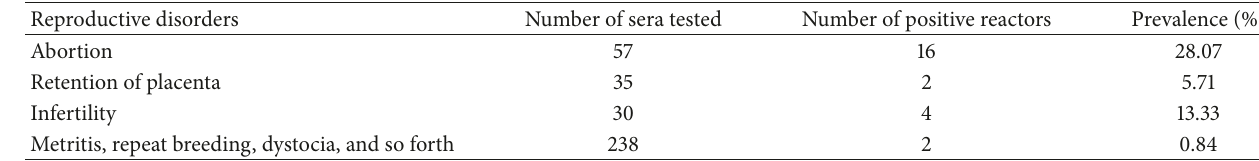
Table 4: Seroprevalence of brucellosis in cattle associated with reproductive disorders.